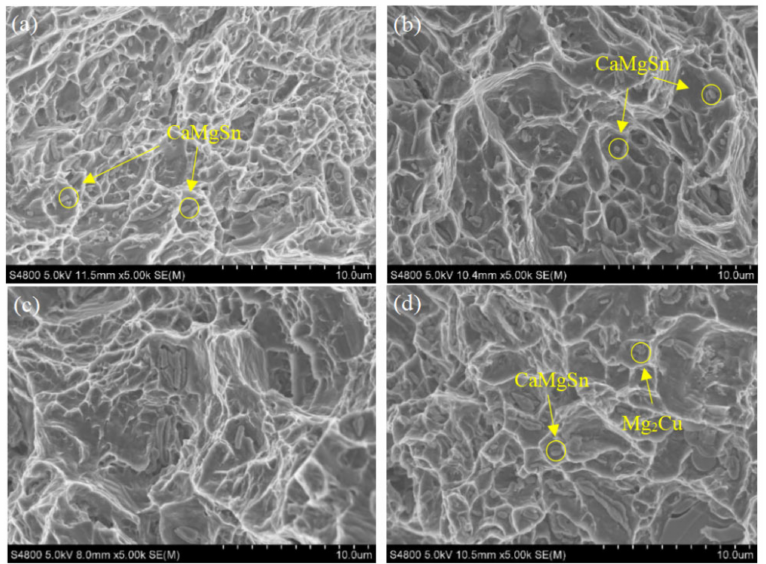
Figure 9. SEM morphology of tensile fracture of as-extruded alloys at room temperature, ( a ) TX31; ( b ) TXZ311; ( c ) TXC311; ( d )